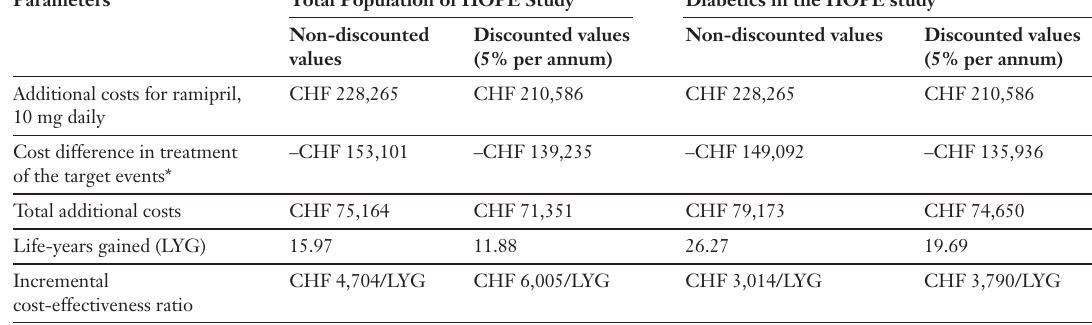
(per 100 patients) – Incremental costs, incremental effects and incremental cost- effectiveness ratio of ramipril compared to placebo.